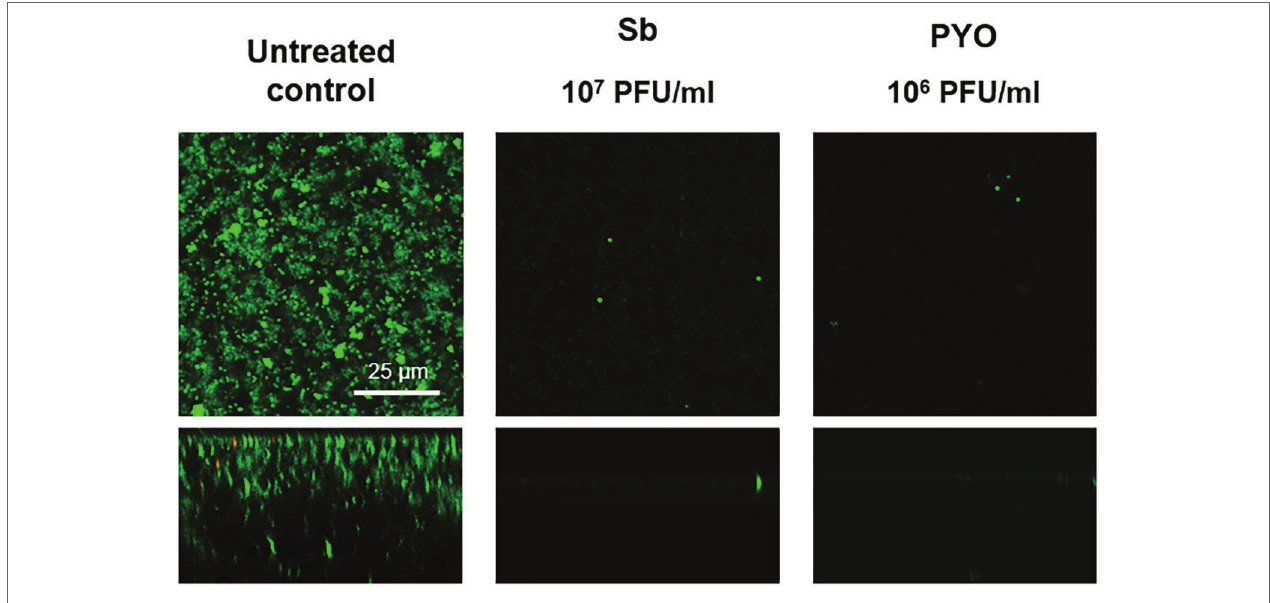
FIGURE 7 | CLSM images of MRSA ATCC 43300 biofilm untreated and treated with Sb and PYO. MRSA biofilm (24 h-old) was exposed for 7 and 5 days to 10 7 PFU/ml Sb and 10 6 PFU/ml PYO, respectively. The viability of the cells was evaluated staining with green fluorescent labeled SYTO9 (488/500–540 nm) for alive bacteria and with red fluorescent propidium iodide (PI) (561/600–650 nm) for dead bacteria. Images are merged from the two channels. Upper and lower panels represent xy- and z-plans, respectively. Scale bar: 25 μ m.